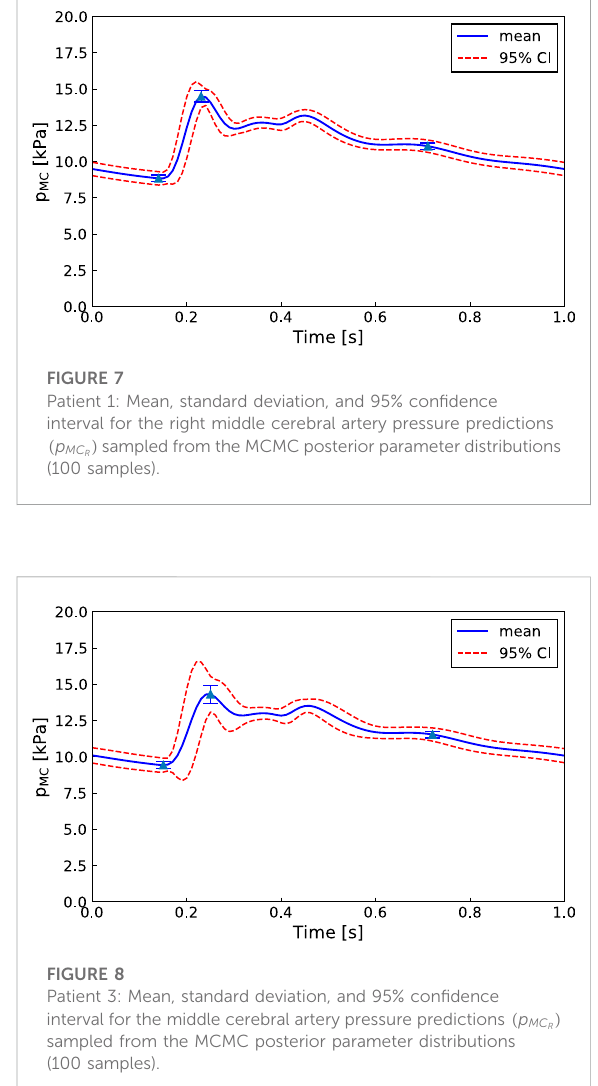
FIGURE 8 Patient 3: Mean, standard deviation, and 95% con fi dence interval for the middle cerebral artery pressure predictions ( p MC R ) sampled from the MCMC posterior parameter distributions (100